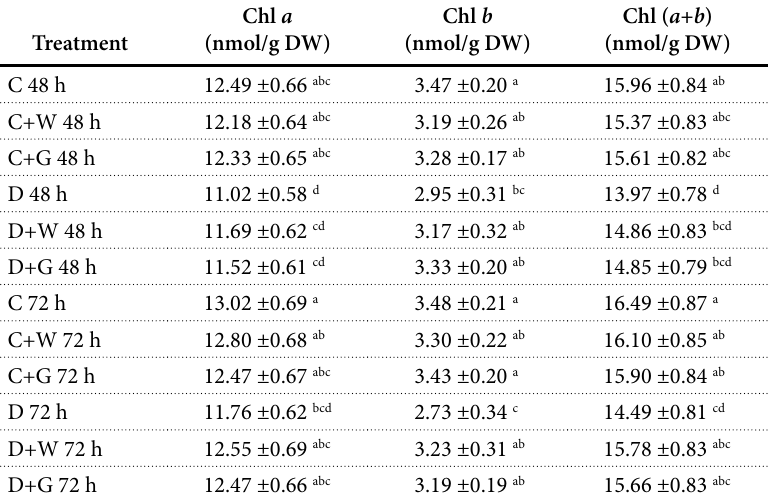
Tab. 1 Effect of exogenous GA on chlorophyll concentrations in wheat